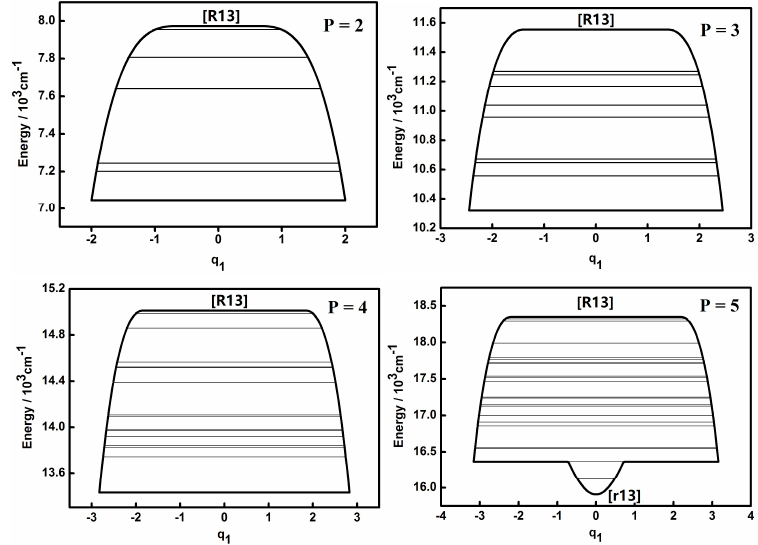
Figure 5. Dynamic potentials of the non-integrable HOCl system (obtained with H ( q 1 ,p 1 ,q 2 ,p 2 ,P ) , q 1 coordinate) with P = 2, 3, 4, 5, and the energy levels included in the dynamic potential are shown by the lines.